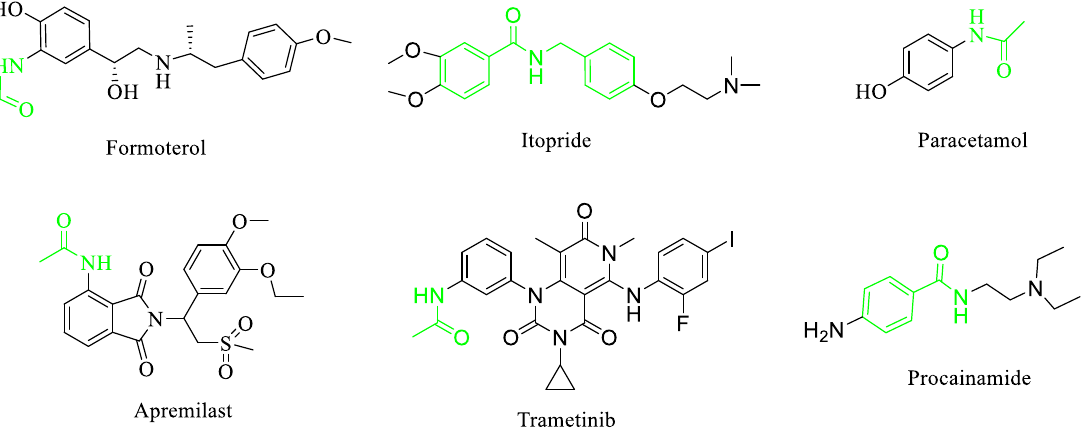
Figure 1. Amide bonds in some drug molecules .